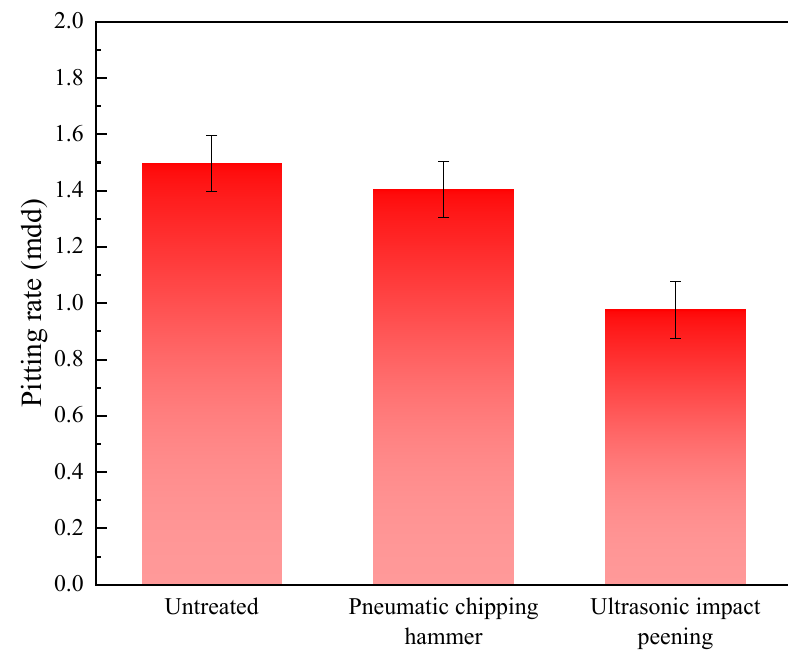
Figure 6. Pitting rate of the welded joints with different treatment methods.